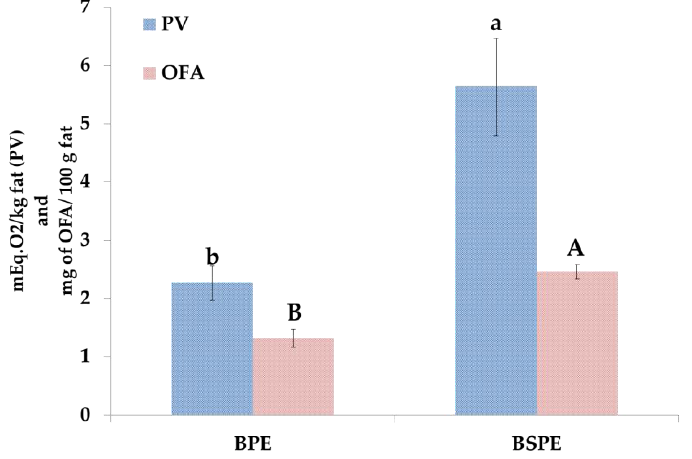
Figure 4. PV and OFA content in biscuits. Different letter means statistical difference ( p < 0.05) . PV: peroxide value; OFA: oxidize fatty acids.